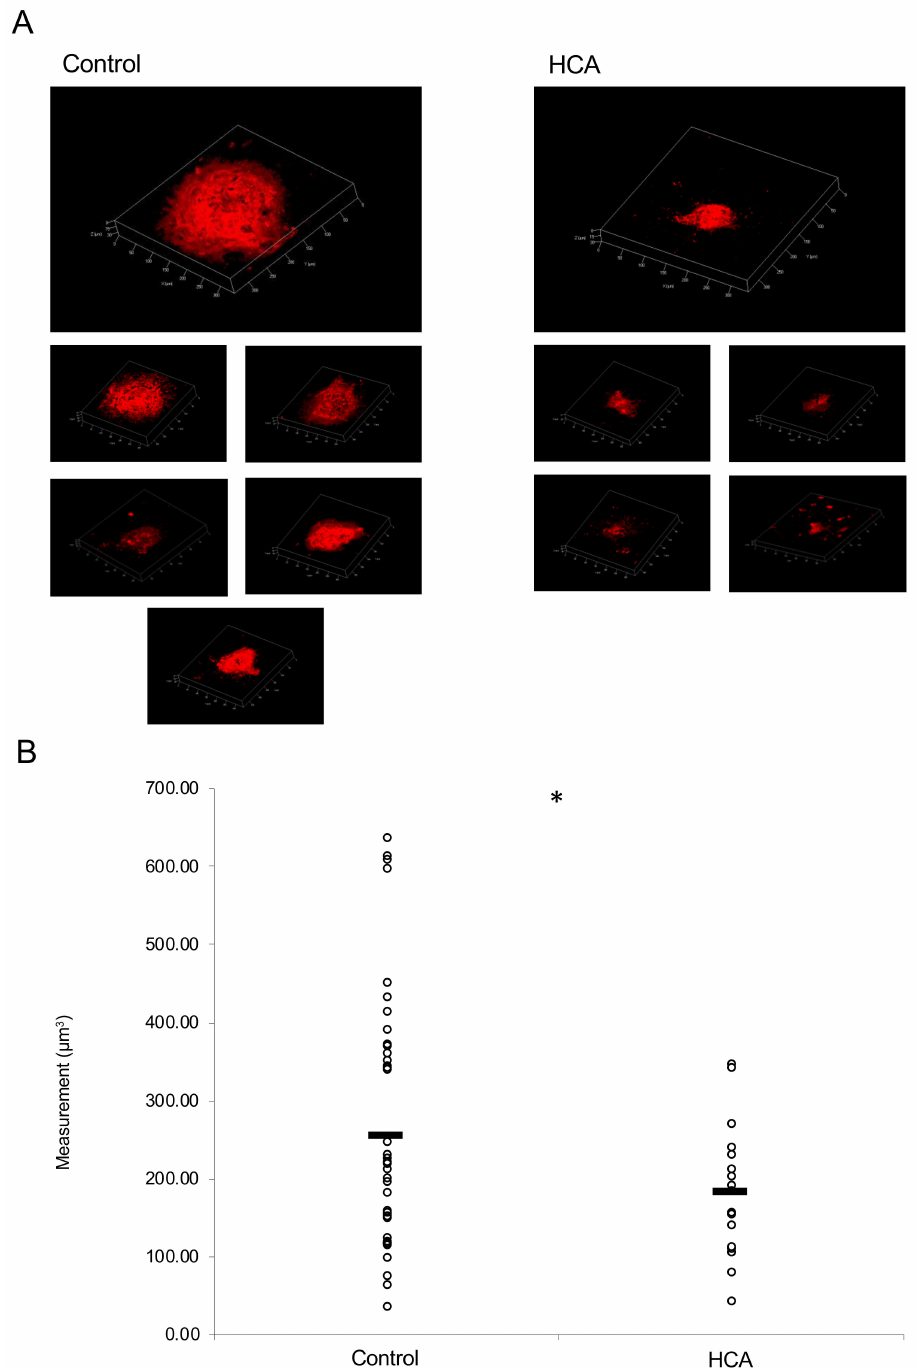
Figure 6. Administration of HCA suppressed CNV volume in mice. ( A ) Representative three-dimensional images of IB4-stained CNV. Individual CNV from each mouse was shown. ( B ) Quantification of the laser-induced CNV volume. Note that the administration of HCA significantly reduced the CNV volume when compared with the control group. Control: 278.05 ± 186 µ m 3 , HCA 195.87 ± 107.57 µ m 3 , n = 25, and 44 for control and HCA, respectively. Six and five mice for control and HCA, respectively. Control group: 25 CNV, six mice, HCA: 44 CNV, five mice, * p <